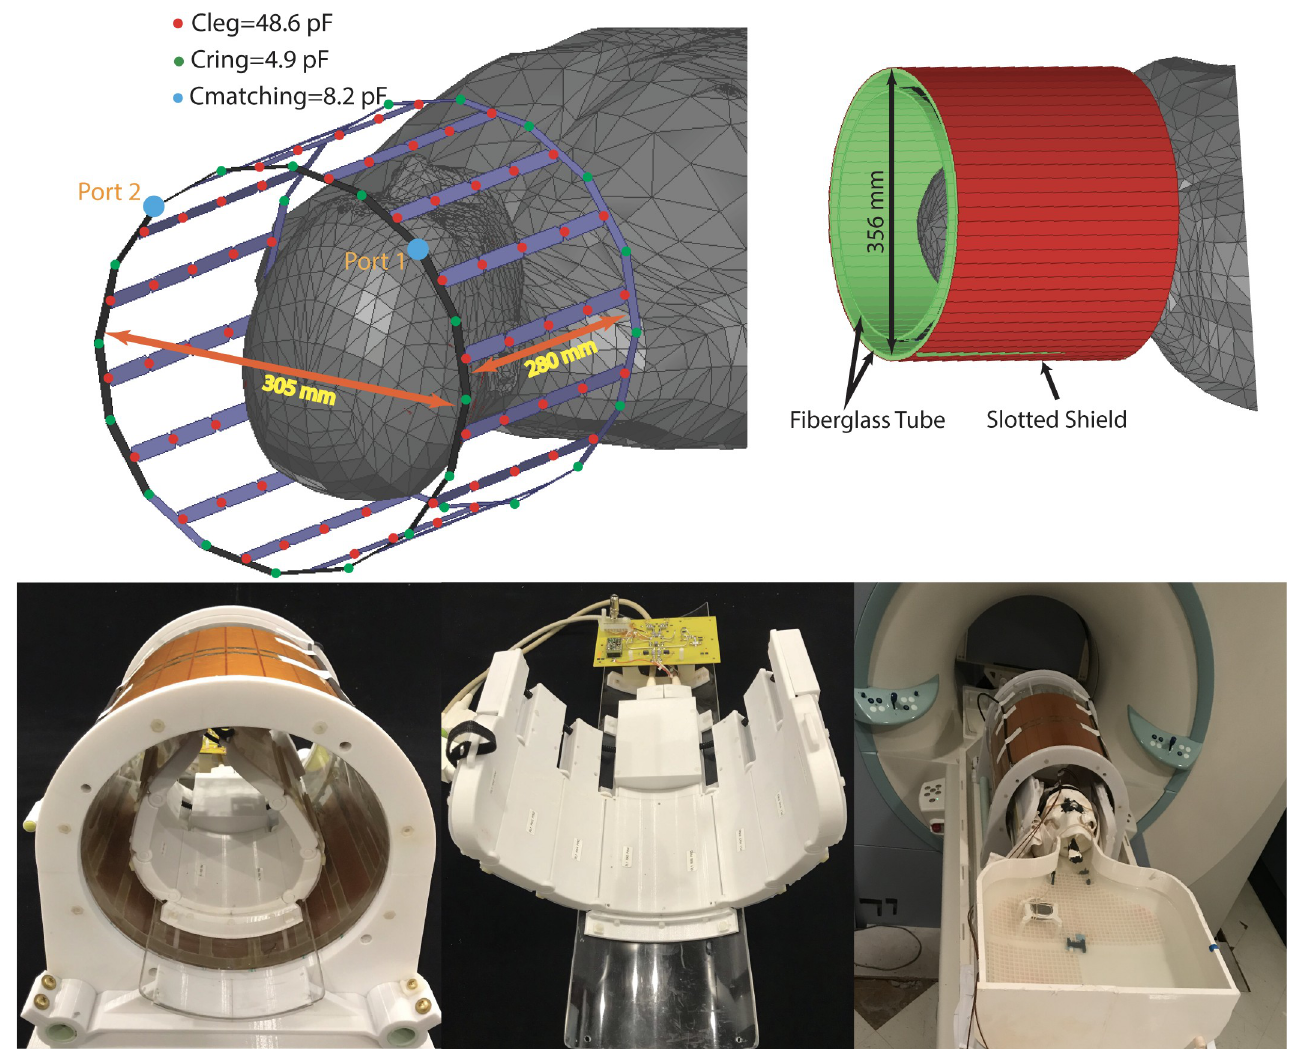
Fig 1. RF coil and phantom